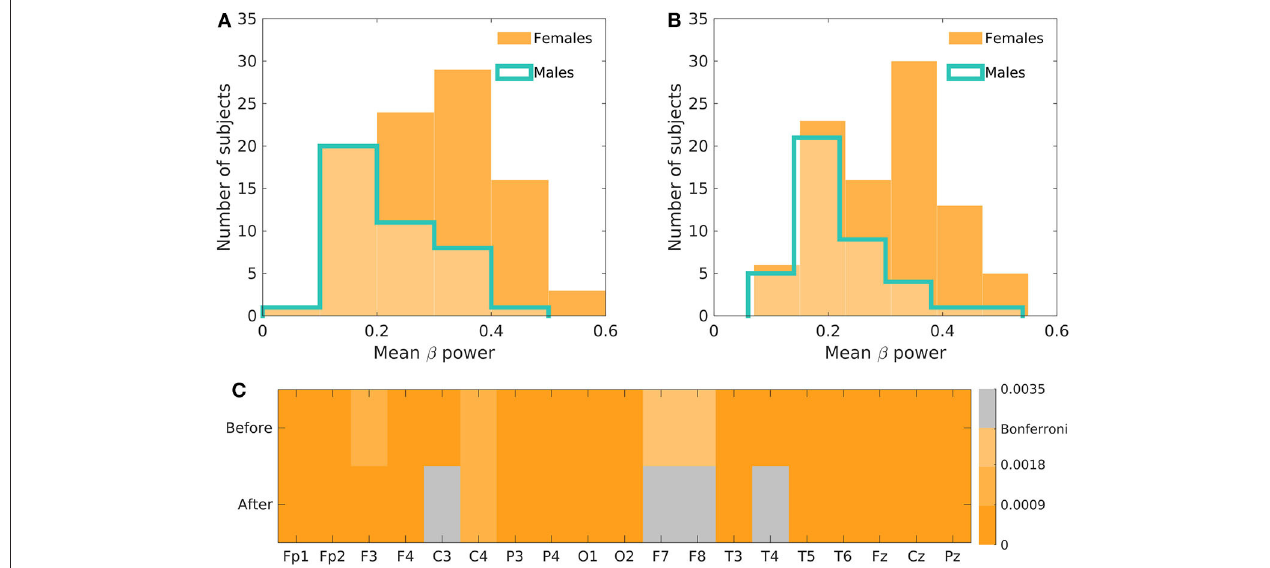
FIGURE 1 | The initial assessment of the beta-power difference between men and women. (A) Depicts the histogram of the mean beta power in men and women before the antidepressant treatment and (B) after the treatment. (C) Shows the Bonferroni corrected p -values of the relative beta power differences across all electrodes before and after the treatment.